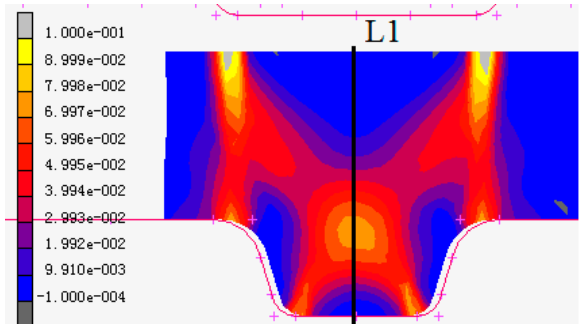
Figure 7. Strain distribution of the first pass of cold pressing.